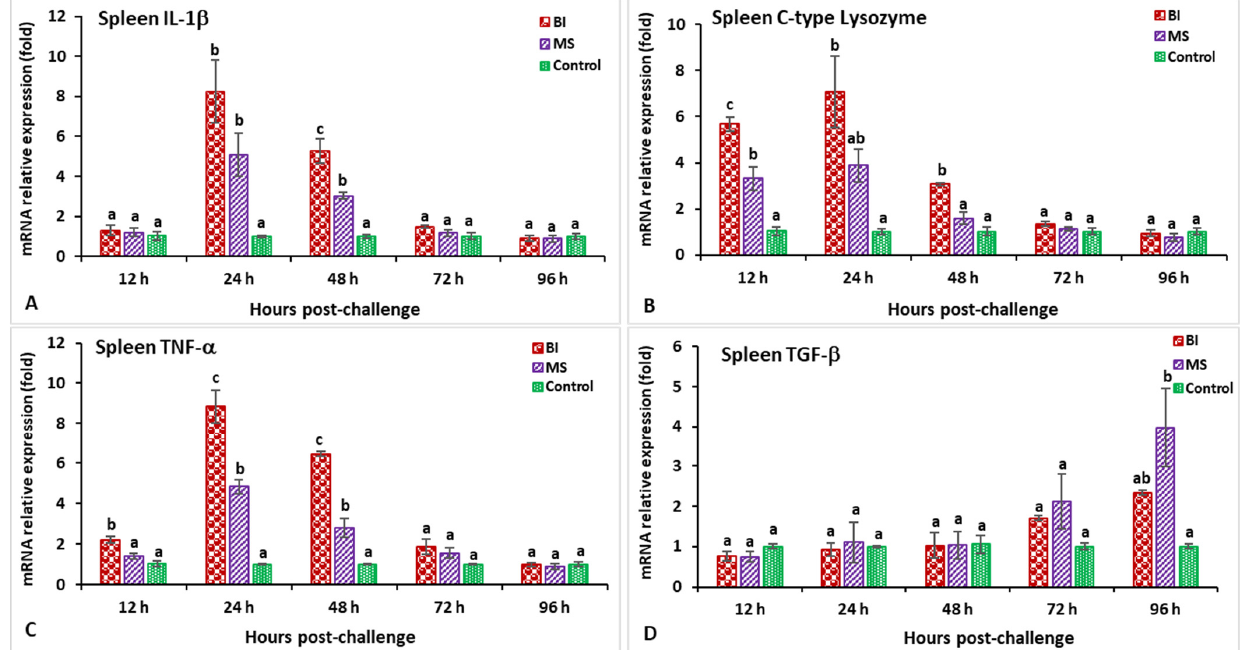
Figure 3. The gene expression of IL-1 β ( A ), C-type lysozyme ( B ), TNF- α ( C ), and TGF- β ( D ) in the spleens of orally vaccinated fish after being challenged by Streptococcus iniae (mean ± SE, n = 3). Dissimilar letters denote significant differences ( p < 0.05).